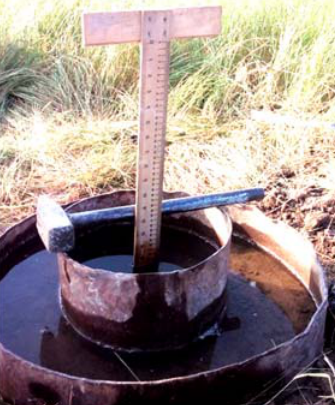
Fig. 3: Permeability determination by double ring method in the first layer of rainfed farming